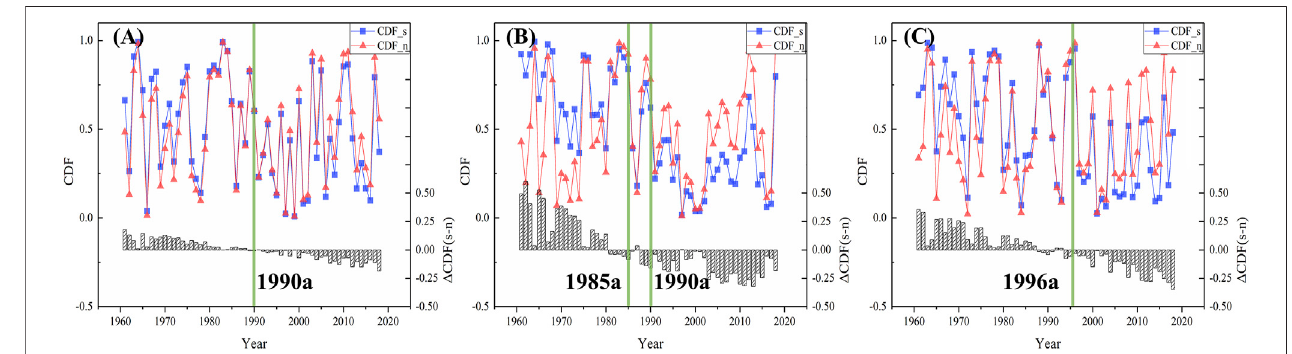
FIGURE 5 | Comparison of the cumulative probability distribution for annual runoff series at (A) DJK, (B) HYK, and (C) UR.